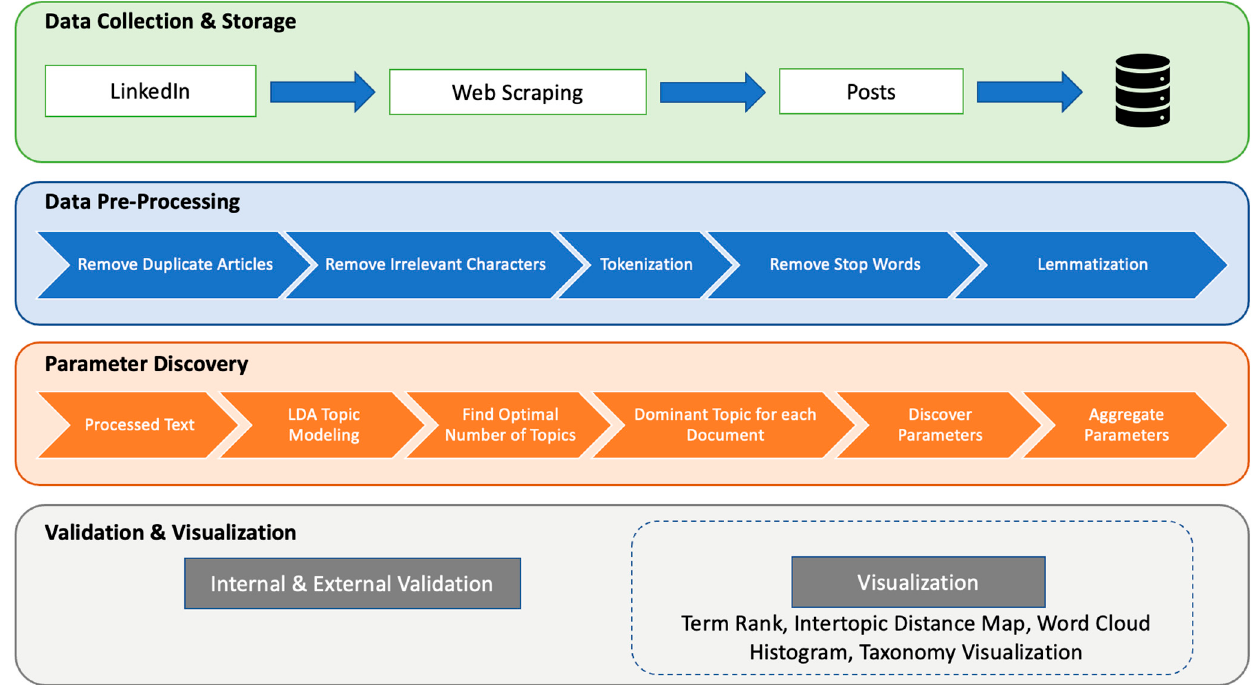
Figure 1. The System